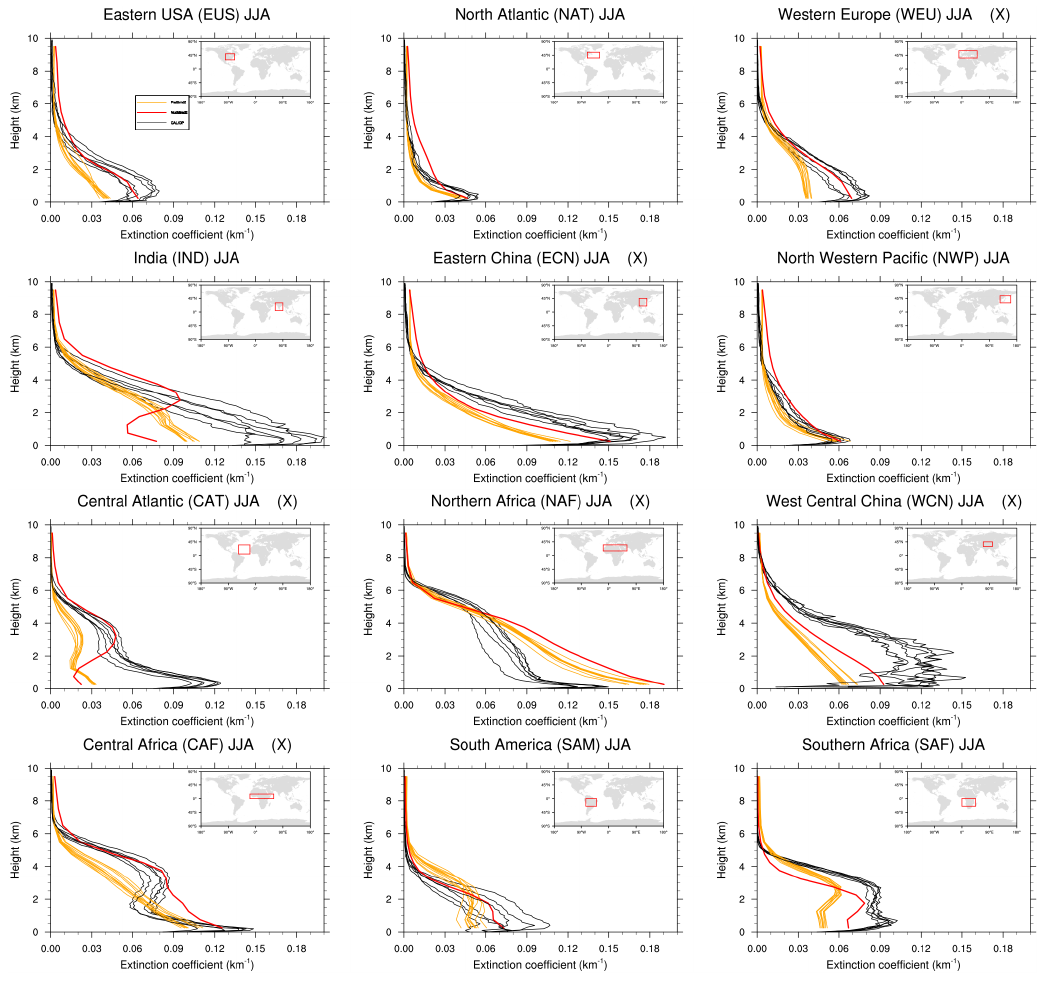
Figure 17. Same as Fig. 16, for the JJA